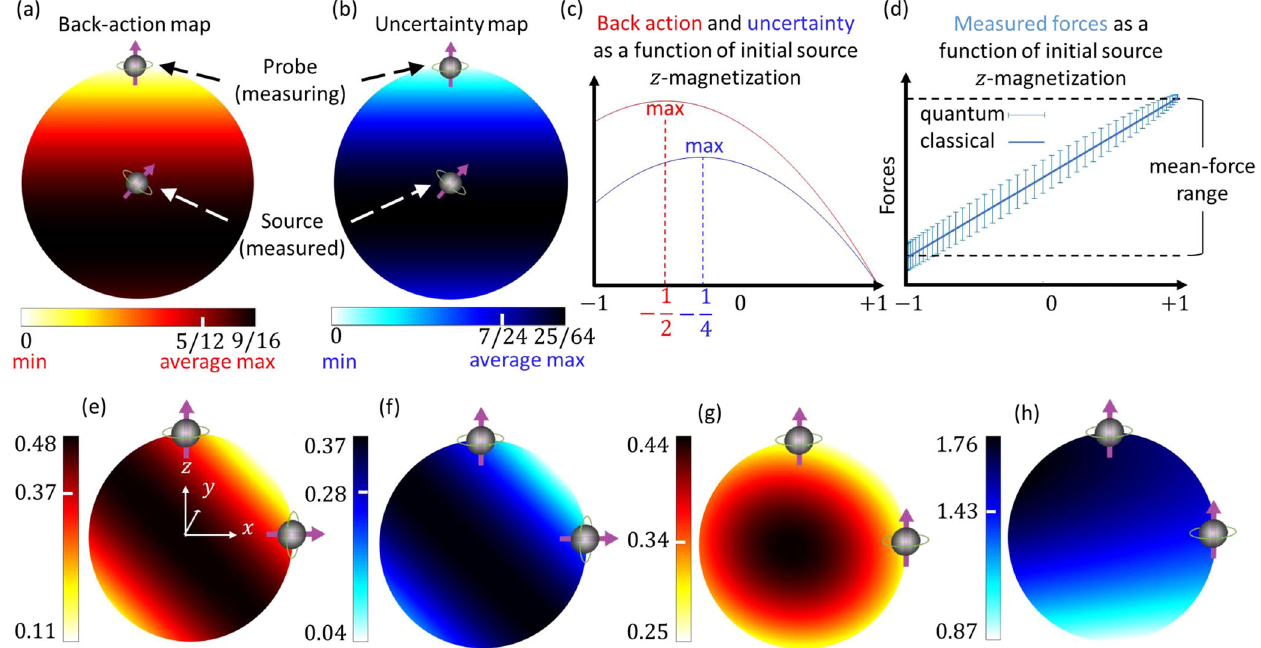
Fig. 2 Quantifying the limits of quantum measurements. Using the back action on the source spin and the uncertainty of its measured value. a , b Both criteria are evaluated and plotted on the Bloch spheres, with the position on the sphere denoting the initial state of the source spin. All the spins in this fi gure are spin-1/2 and the Bloch spheres are oriented such that their north pole represents the source state 1 = 2 j i . In each case, the position and orientation of the probe spins are marked on the shell of the spheres. The minimal, maximal, and averaged value of each map is marked on its color bar. c One-dimensional cuts of ( a ) and ( b ), as a function of the source ’ s initial z -magnetization, corresponding to the altitude in the sphere (cos θ ). Note that these cuts represent any azimuthal angle since the maps in ( a , b ) are azimuthally symmetric. d The measured forces as a function of initial z -magnetization. Error bars represent the standard deviation of the quantum- measured force distribution. The mean of each error bar resembles the classical value of the force, as expected from the correspondence principle. The uncertainty is calculated based on the standard deviations and the mean-force range (marked on the right). Note the correspondence between ( c ) and ( d ): larger error bars in ( d ) correspond to higher uncertainty values in ( c ). The least (most) back action and measurement uncertainty occurs from source spins states represented at the north pole (a bit below the equator). e – h Back-action ( e , g ) and uncertainty ( f , h ) maps for double-spin probes; color bars are marked with minimal, average and maximal values. All maps in ( e – h ) have xz - plane symmetry due to similar symmetry in the probe spatial distribution, thus only the hemisphere y > 0 is shown. The differences between ( e , f ) and ( g , h ) are caused by the different orientation of the probe spin at the equator, creating a substantial increase in the average uncertainty, almost by a factor of